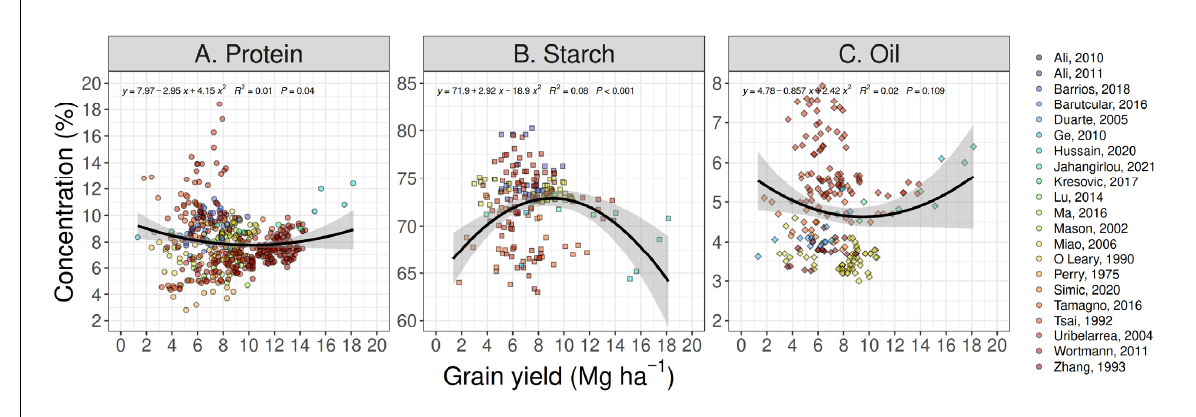
Figure 1. Correlation matrix between protein (( A ), %), starch (( B ), %), and oil (( C ), %), all expressed in concentration (%), considering a subset of studies (11) where the three variables were quantified ( n = 239) (Table 1).